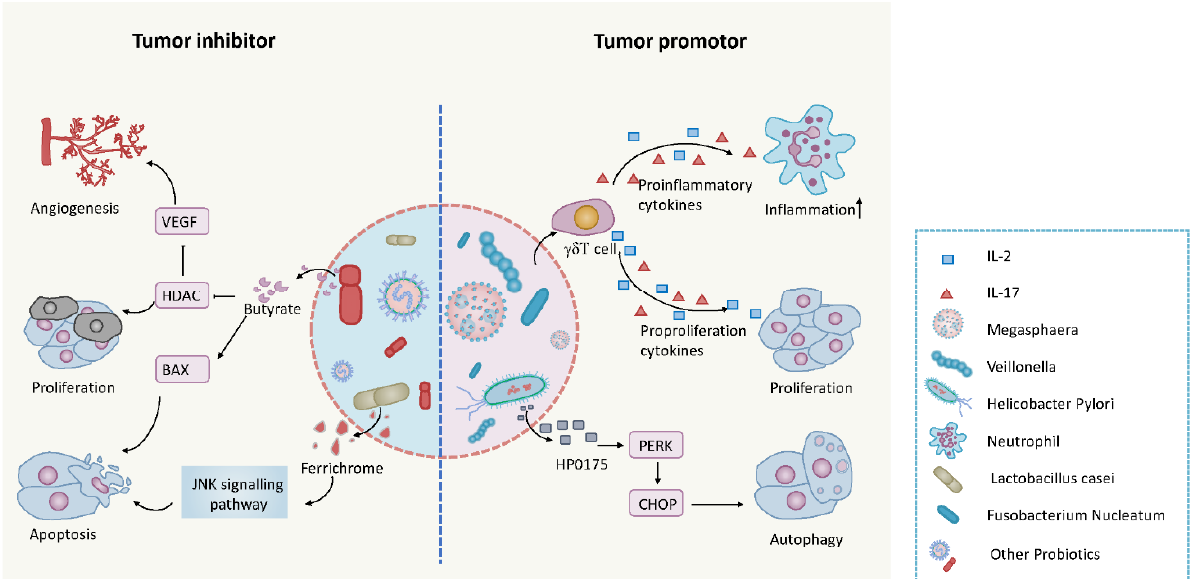
Figure 4. The microbiome plays a dual role in human health and disease. Microbiota and their metabolites can act as either tumor promotors or tumor inhibitors. As tumor promotors they can secrete antigens or cytokines to induce adaptive autophagy, inflammation and tumor proliferation promoting tumor progression. Microbes, especially some Gram-negative bacteria, can be directly or indirectly involved in cancer progression and regulation. For example, local microbiota can provoke inflammation associated with lung adenocarcinoma by activating lung-resident γδ T cells and promoting tumor cell proliferation by secreting IL-22 and Areg [148]. The secreted antigen, HP0175, of Helicobacter pylori links the unfolded protein response (UPR) to autophagy in gastric epithelial cells. Helicobacter pylori secrete HP0175, inducing adaptive autophagy to promote tumor cell survival [149]. As examples of tumor inhibitors, ferrichrome, secreted from Lactobacillus casei , can induce colon cancer apoptosis [150]. Some probiotic proteins and metabolites have antineoplastic activity. For example, butyrate shows great anti-cancer potential by inhibiting angiogenesis and proliferation and inducing apoptosis [151].